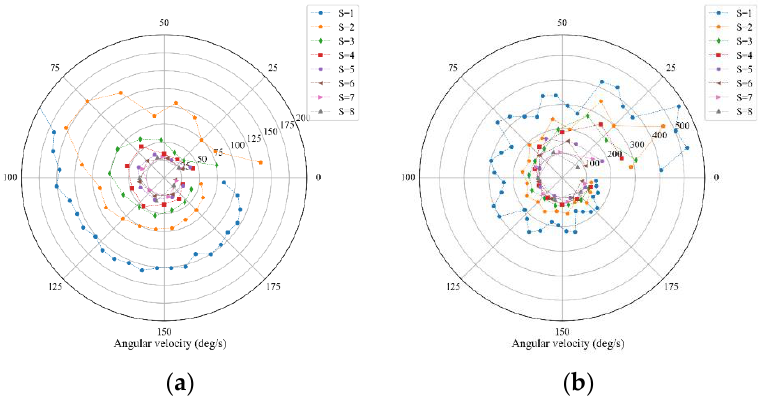
Figure 24. Angular velocity. ( a ) Flat surface; ( b ) Convex pattern